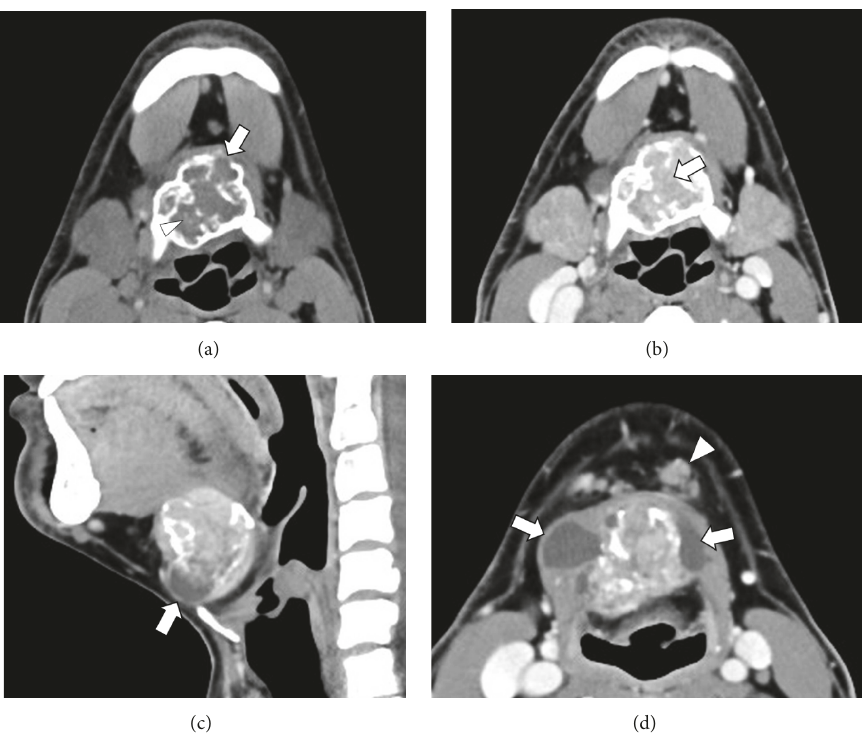
Figure 1: CT of the neck. (a) Axial noncontrast CT at the level of the hyoid bone shows a well-defined, low-density mass expanding the cortex of the hyoid bone with partial bone destruction (arrow). Punctate calcifications are seen within the mass (arrowhead). (b) Axial contrast- enhanced CT at the same level as (a) shows marked enhancement of the solid component (arrow). (c, d) Sagittal at the midline (c) and axial at the infrahyoid level (d) images of contrast-enhanced CT show the mass consists of a solid component and a marginal cystic component (arrows). Left submental lymphadenopathy is also seen (arrowhead).